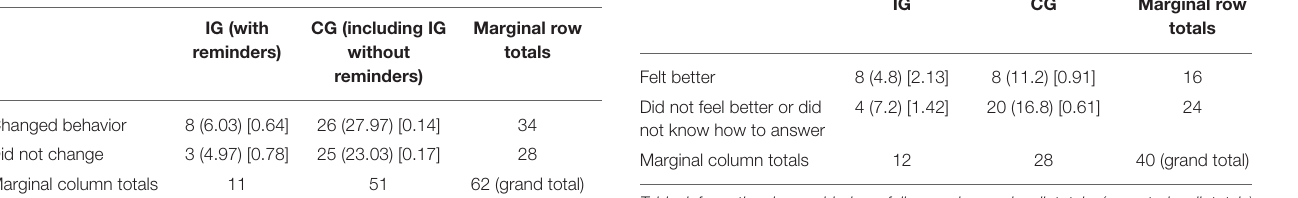
Table information is provided as follows: observed cell totals (expected cell totals) [chi-square statistic for each cell].